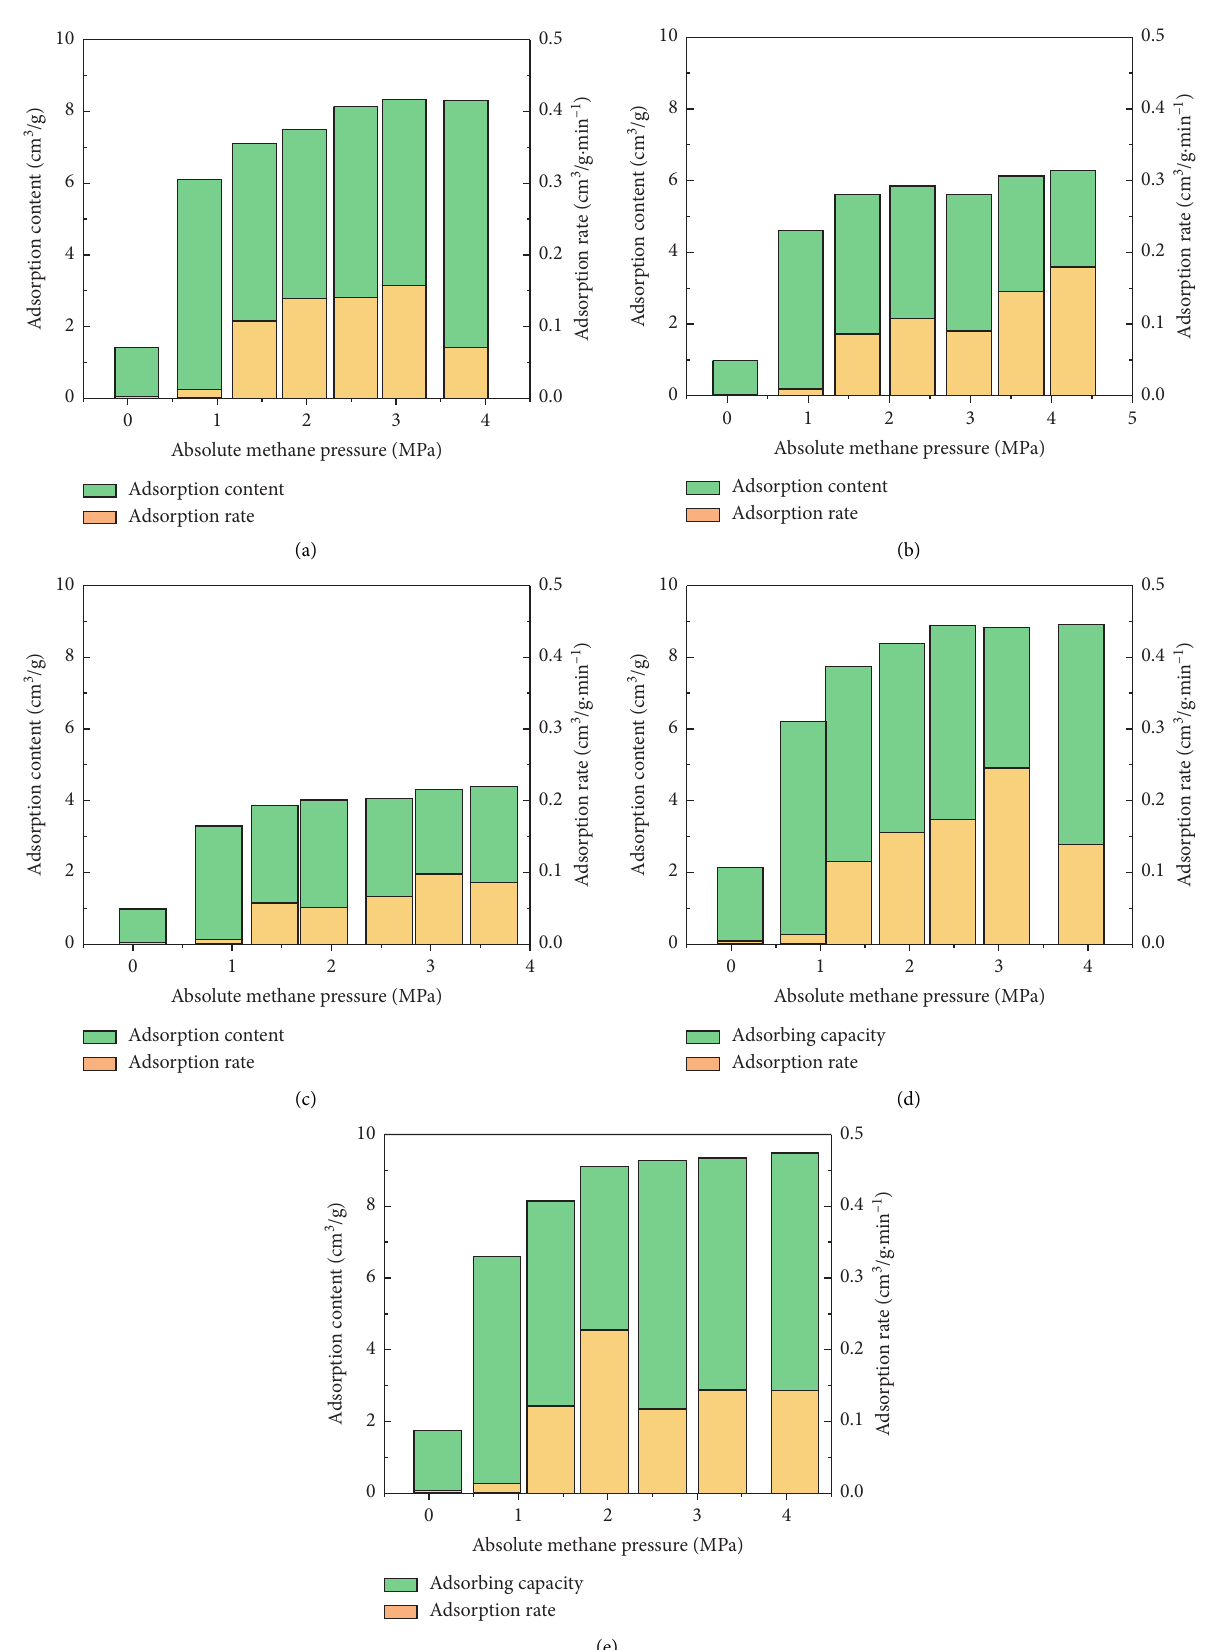
Figure 12: Relationship between methane adsorption content and rate: (a) 1 # raw coal, (b) 2 # coal with static blasting material during heat action, (c) 3 # coal during heat action, (d) 4 # coal with static blasting materials after heat action, and (e) 5 # coal after heat